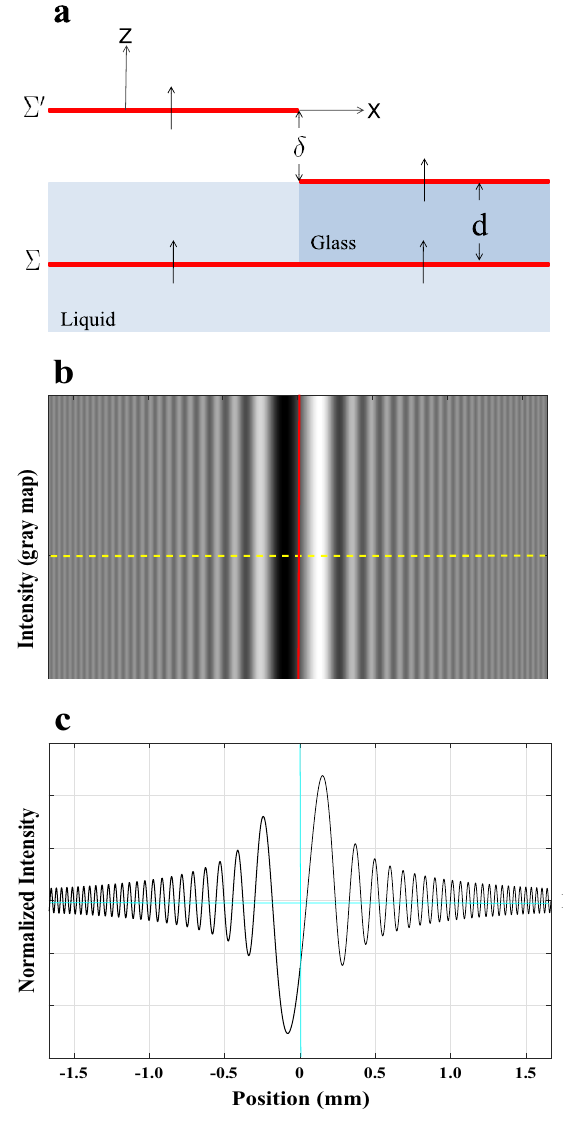
Figure 2. ( a ) The optical length of a direct ray at normal incidence is shown to illustrate the production of a phase step after passing a coherent monochromatic plane wave-front from two adjacent phase objects with different refractive indices. ( b ) A simulation of the intensity outlook determined at a distance of R = 5 cm from the back of the glass plate. ( c ) Calculated normalized intensity distribution of diffracted light along the yellow dashed line, corresponding to ( b